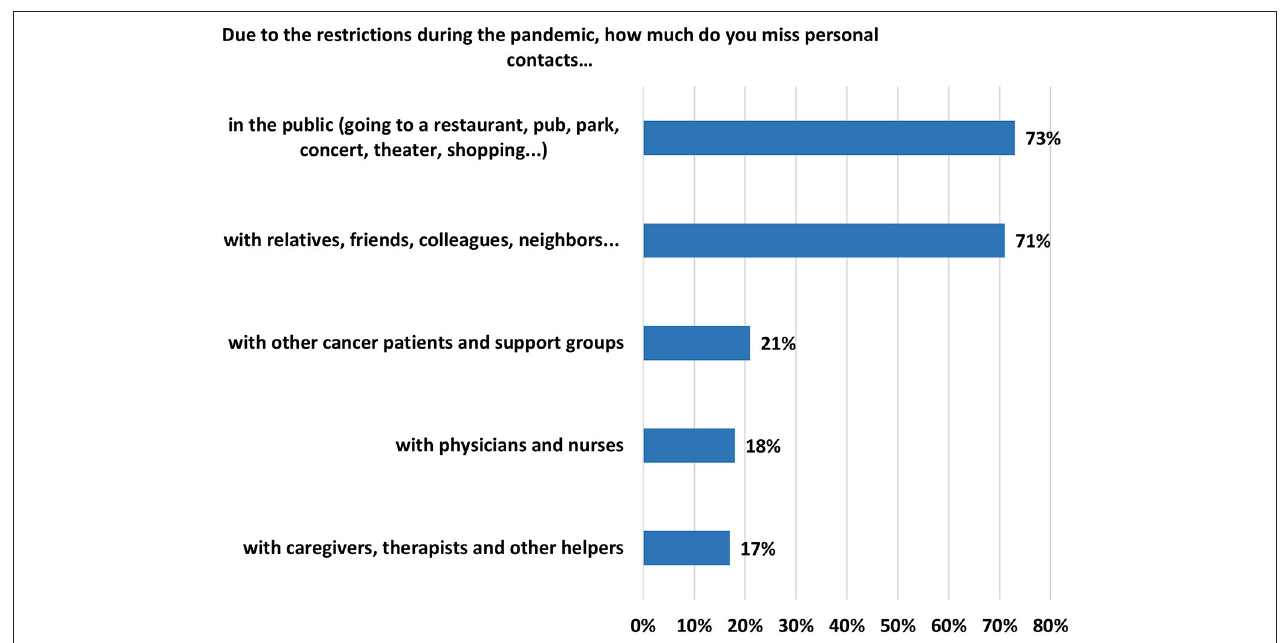
FIGURE 3 | Agreement or strong agreement to missing personal contacts due to restrictions during the pandemic (“miss it quite a bit or very much”).